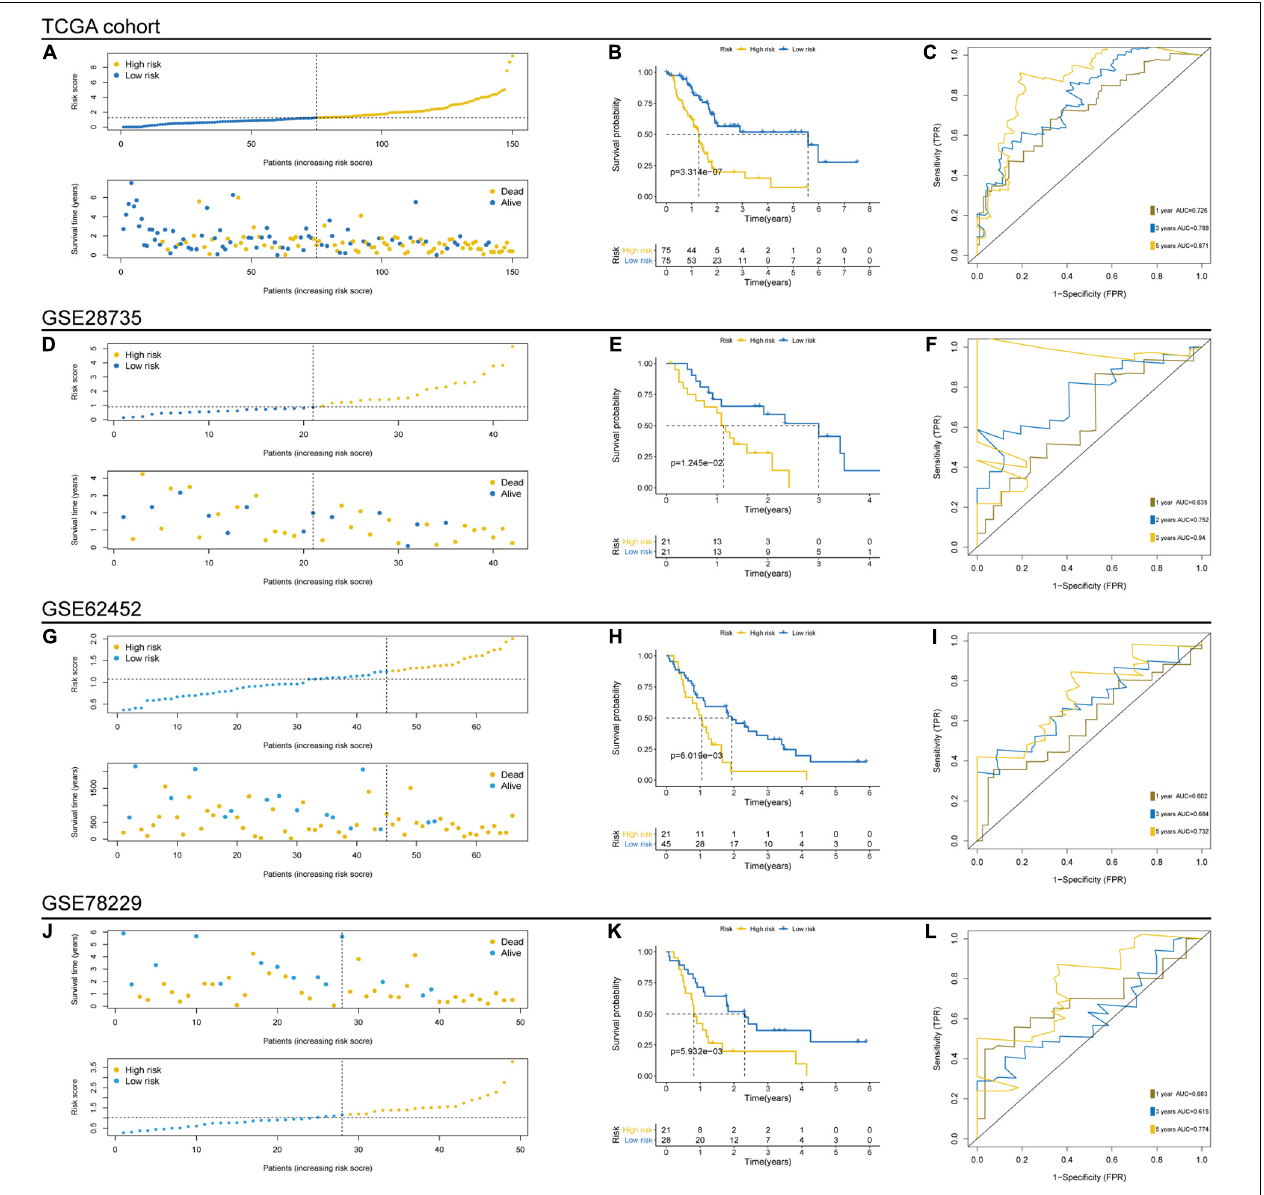
FIGURE 3 | Prognostic evaluation and independent validation of the TP53-associated signature in The Cancer Genome Atlas (TCGA) and Gene Expression Omnibus (GEO) cohorts. Risk score arrangement, survival status, Kaplan–Meier and time-dependent receiver operating characteristic (ROC) analyses in TCGA (A–C) , GSE28735 (D–F) , GSE62452 (G–I) , and GSE78229 (J–L)